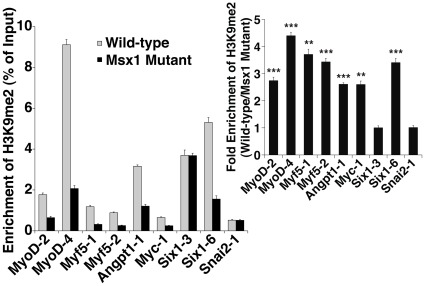
Msx1 genomic binding associated with enrichment of the H3K9me2 repressive mark in the developing limb.ChIP-qPCR analyses show relative levels of H3K9me2 at Msx1 genomic binding sites in Msx1; Msx2 conditional mutant versus wild-type limb (13.5 dpc). ChIP data are expressed as relative enrichment of the H3K9me2 mark normalized to input. (inset) ChIP data expressed as fold enrichment in wild-type embryonic limb versus Msx1; Msx2 conditional mutant embryonic limb (and normalized to input). The * indicate the following: ***P<0.0001, **P<0.001, *P<0.01.